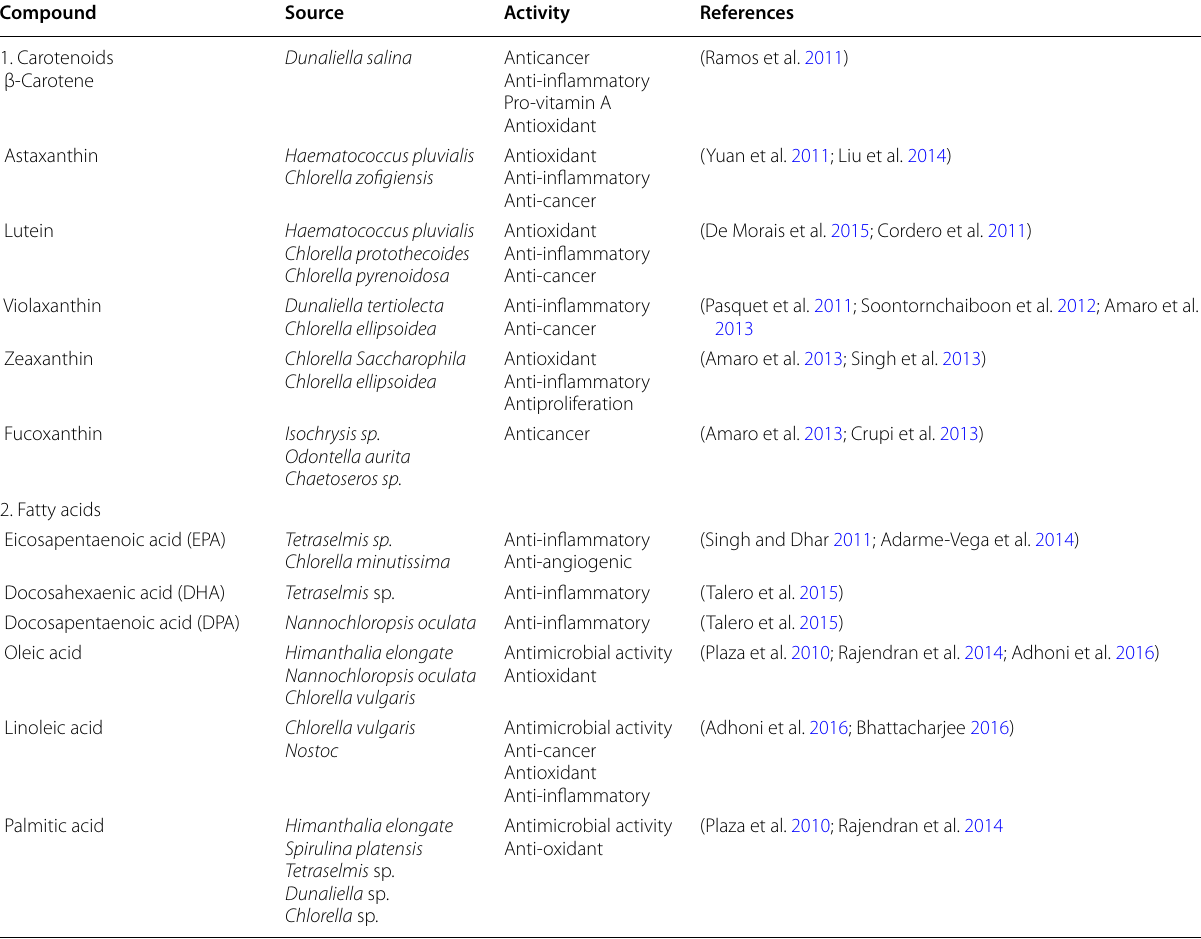
Table 3 Microalgal bioactive compounds and the bioactivities